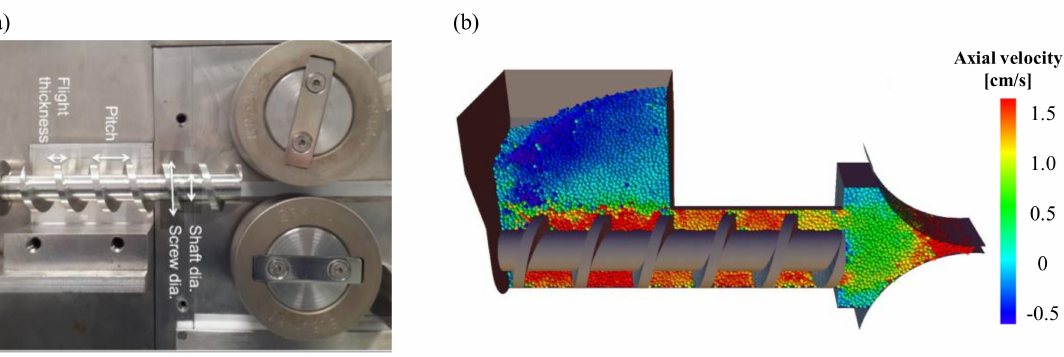
Figure 21. Komarek B050H roll compactor [23]: ( a ) set up of the experiment; ( b ) snapshot of simulation using DEM. The figures were slightly modified, with permission from Elsevier.